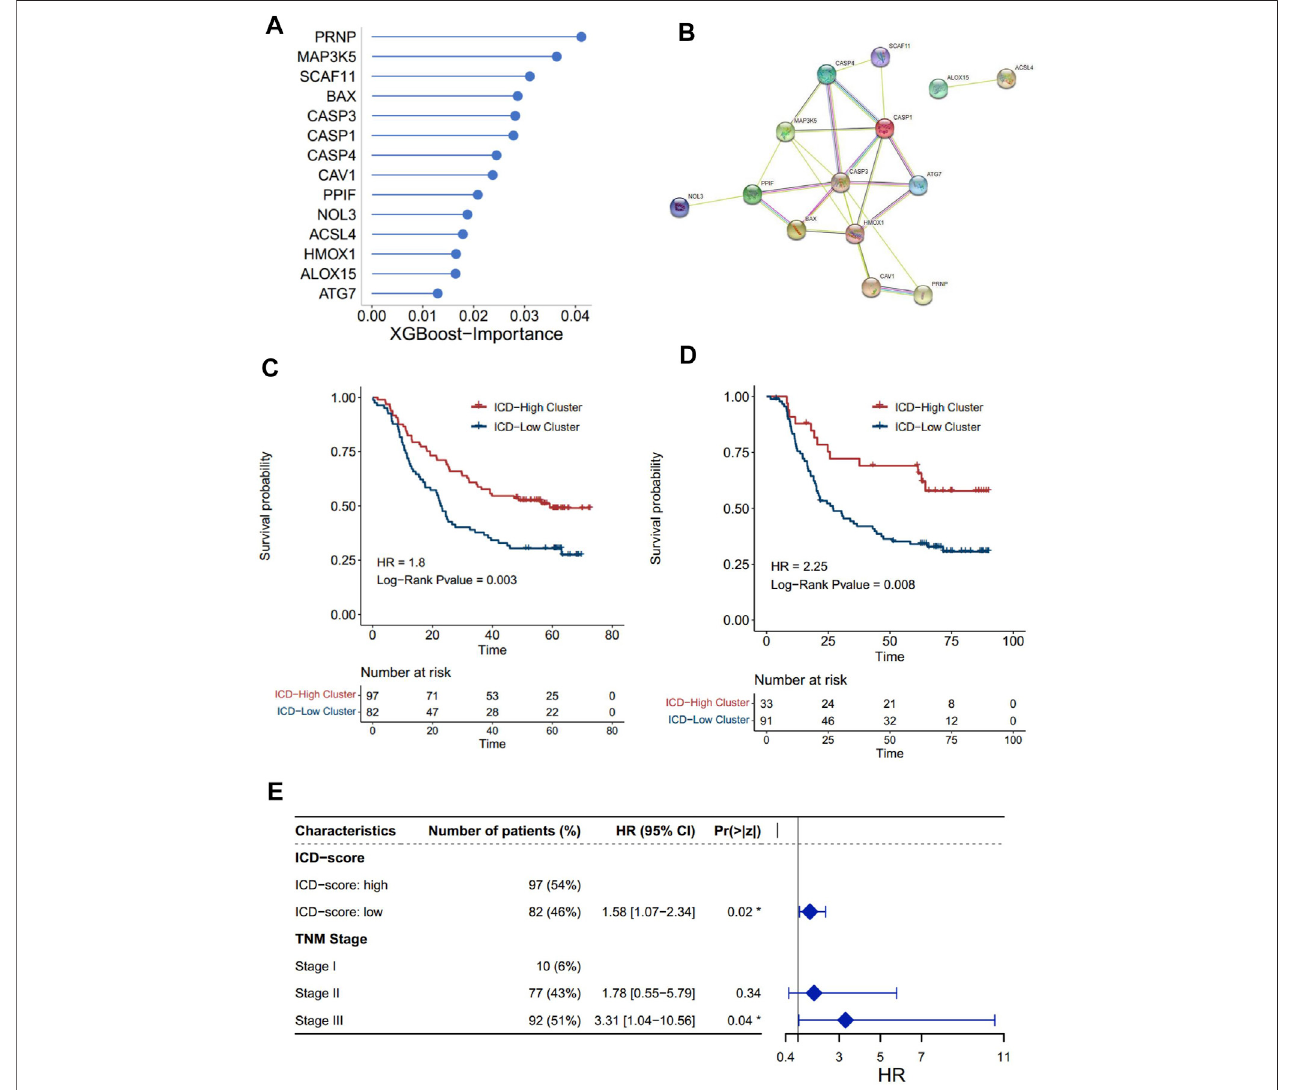
FIGURE5| ConstructionoftheICDscoreandprognosischaracteristics.Theimportanceof14genescalculatedbytheXGBoostalgorithm. (A) Higherimportance valueof agene indicated higher importance. (B) Protein – protein interactionnetworkof 14proteins built by theSTRING database. Thenodes represent the proteins; the line represents the relationship of proteins. (C,D) Kaplan – Meier analysis of overall survival (OS) comparing the ESCC patients with the two ICD score clusters. (C) Kaplan – MeieranalysisofOSinthetranscriptomicslevel. (D) Kaplan – MeieranalysisofOSintheproteomicslevels(redfortheICD-highcluster;bluefortheICD-low cluster). (E) Forest plot: Cox multivariate mode of the ICD-score and the TNM stage in the transcriptomics level.